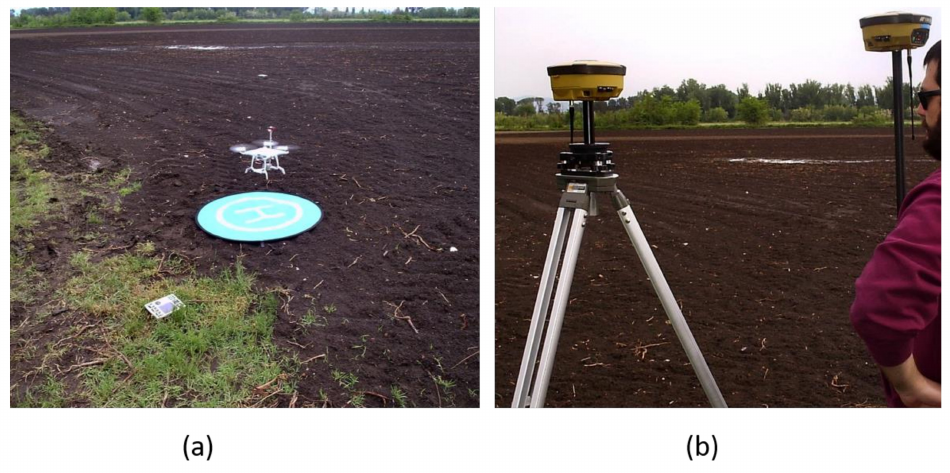
Figure 3. The UAS ( a ) that collected the RGB imagery and the RTK GPS ( b ) used to measure GCPs in this